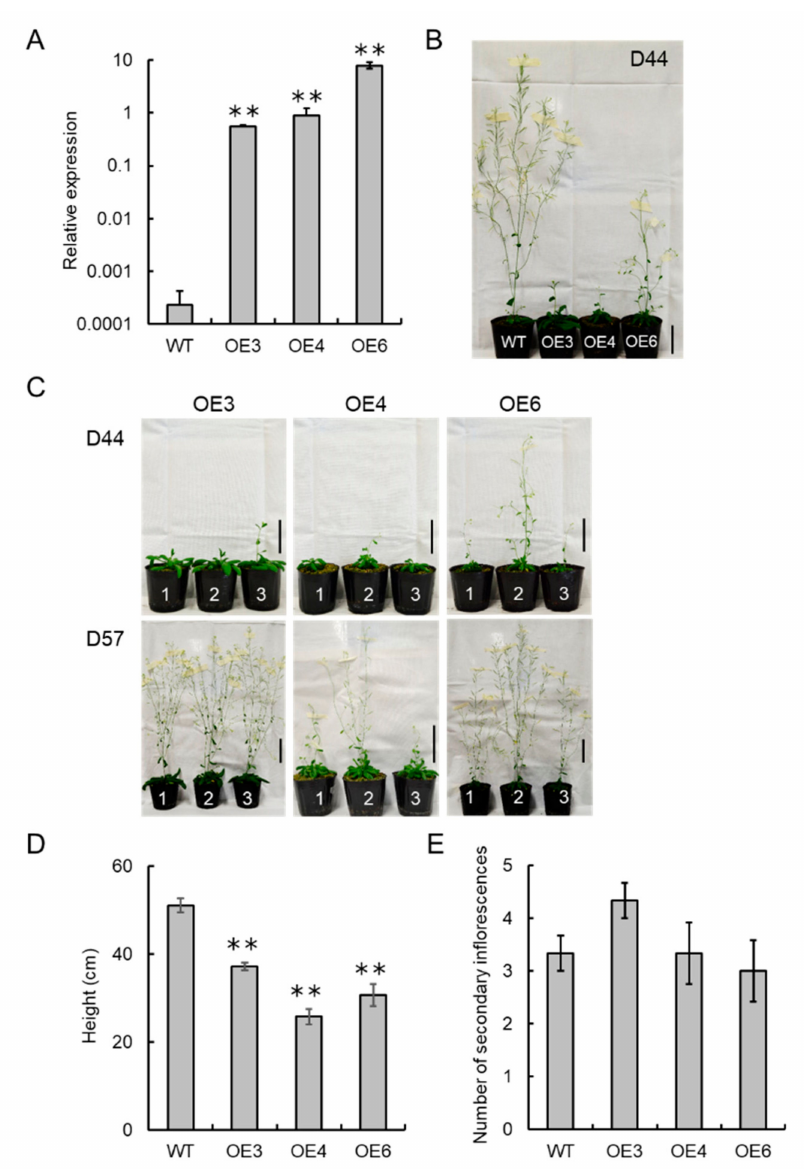
Figure 6. Phenotypes of Arabidopsis plants overexpressing VvCKX5. ( A ) VvCKX5 expression levels in VvCKX5-overexpressing plants. Three independent Arabidopsis lines overexpressing VvCKX5 (VvCKX5-OE3, VvCKX5-OE4, and VvCKX5-OE6) were obtained. Total RNA was isolated from rosette leaves of 36-day-old plants and subjected to real-time RT-PCR. Actin was used as an internal control. Data were calculated as gene expression level relative to actin gene expression level. Bars indicate means ± standard deviations of three independent plants. ** p < 0.01 as compared with wild type (Dunnett’s test). ( B ) Photograph of transgenic and wild type plants on day 44 after sowing. Scale bar = 5 cm. ( C ) Phenotype of transgenic plants on days 44 (D44) and 57 (D57) after sowing. Three plants were observed for each transgenic plant. Scale bar = 5 cm. ( D ) Plant height. Plant height was measured on day 44 (wild type) or 57 (transgenic) after sowing. Bars indicate means ± standard deviations of three independent plants. ** p < 0.01 as compared with wild type (Dunnett’s test). ( E ) Number of secondary inflorescences on wild type and transgenic plants. The number of secondary inflorescences on wild type and transgenic plants was measured on day 42 (wild type) or 57 (transgenic) after sowing, respectively. Bars indicate means ± standard deviations of three independent plants. WT, wild type. OE3, VvCKX5-OE3. OE4, VvCKX5-OE4. OE6,